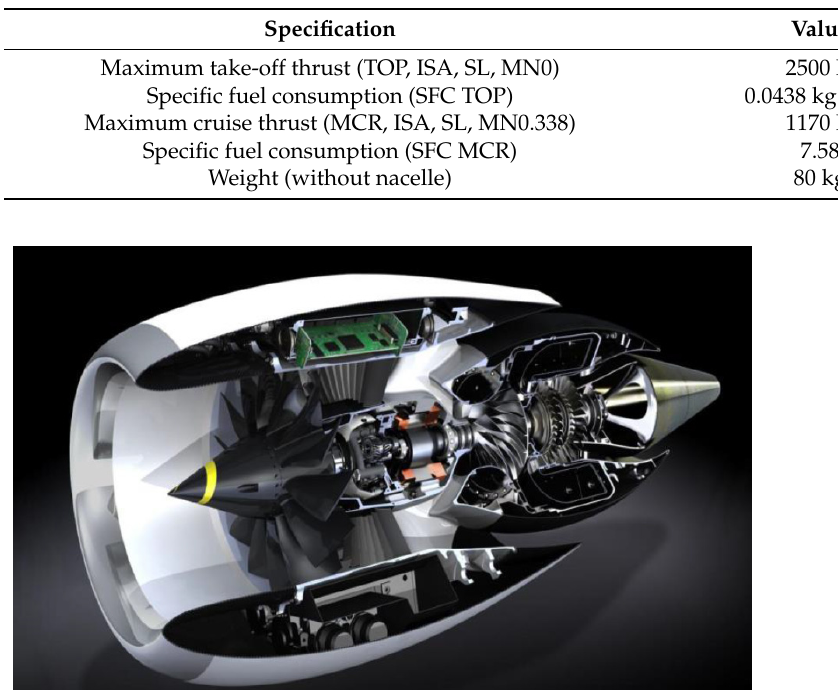
Figure 1. DGEN 380 turbofan engine (Price Induction © , Anglet, France).